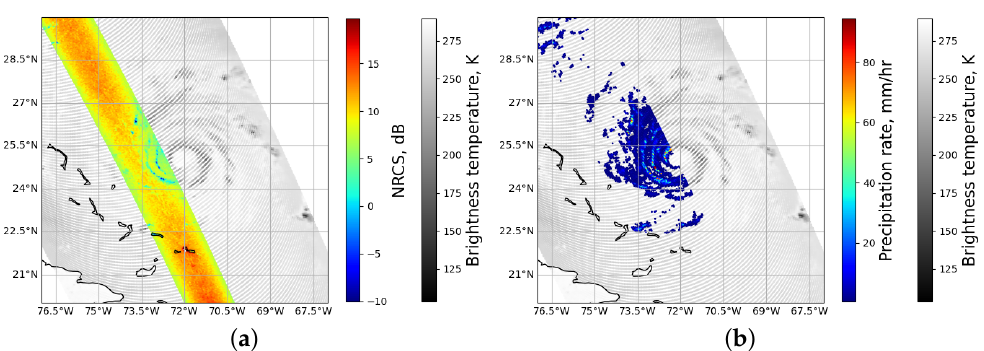
Figure 1. ( a ) Raw data of Ku-band radar over the image of brightness temperature from the GPM Microwave Imager (GMI) data at 89 GHz, V-polarization. The track passed over Hurricane Maria at 12:15 UTC on 23 September 2017; ( b ) rain